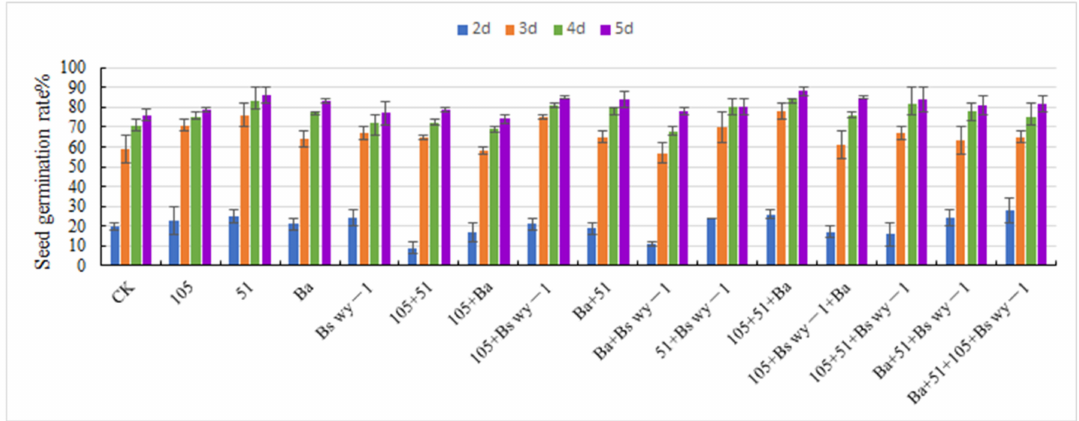
Figure 1. Germination rate of tomato seeds under the treatment of single and compound combined bacterial